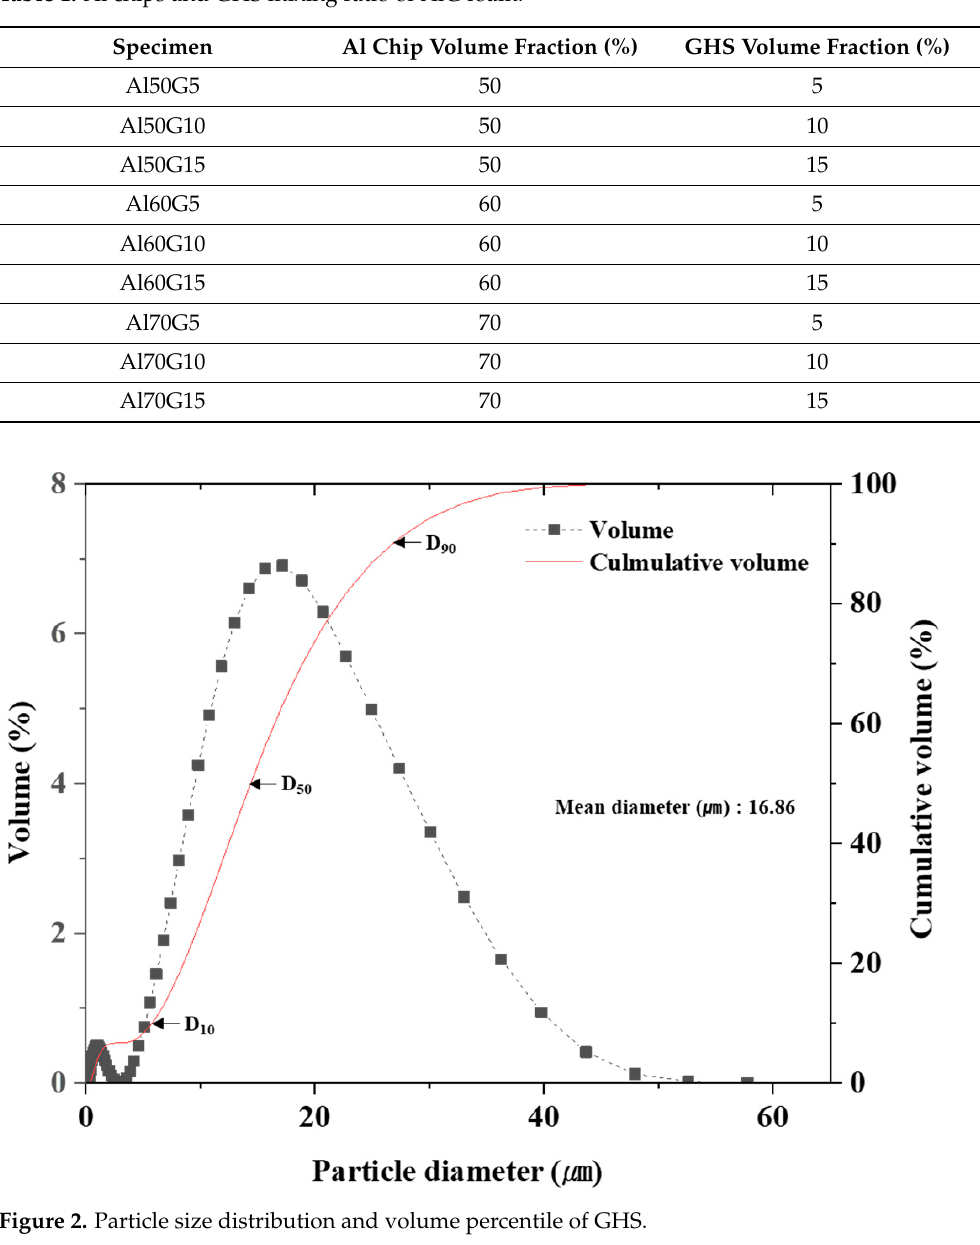
Table 1. Al chips and GHS mixing ratio of AlG foam.